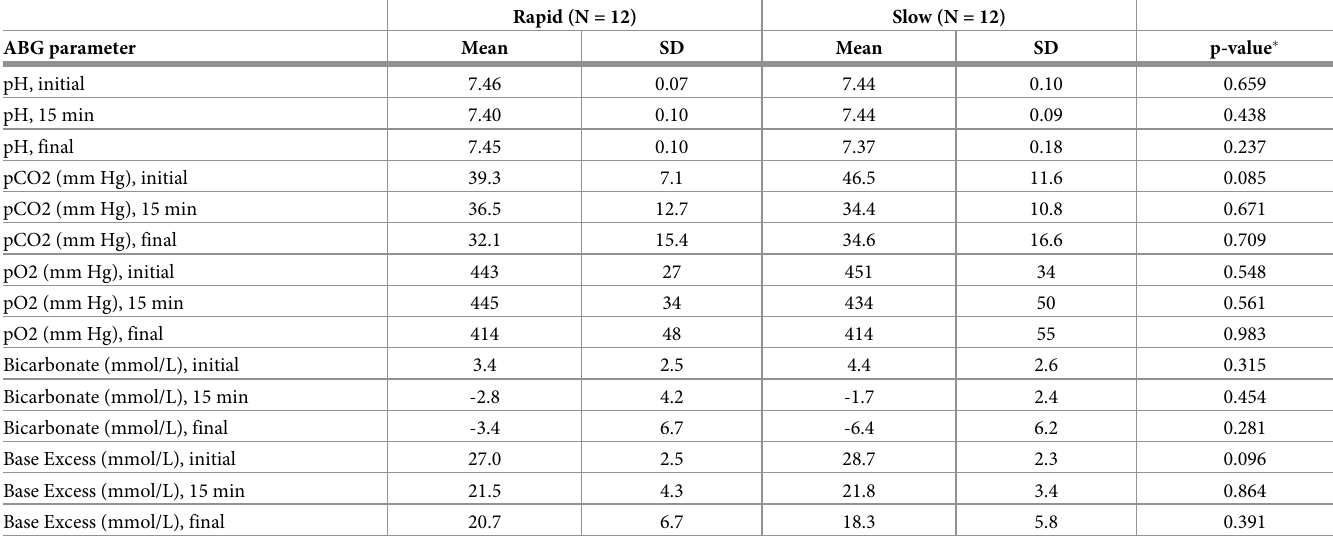
Table 5. Arterial blood gas